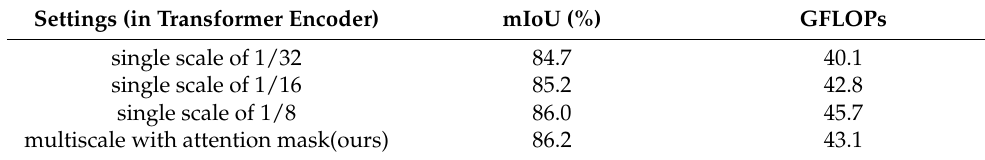
Table 5. Effect of different resolution features. Table 4. Effect of the component in the transformer decoder.